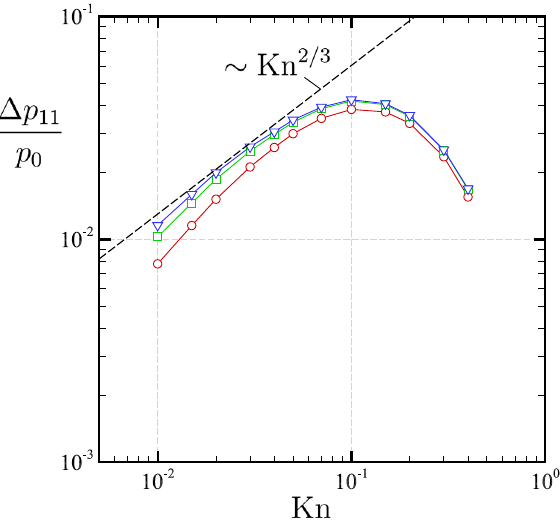
D D ( p 11 ( x 1 0, x 2 ) 0, 0 )) versus Kn . sup p 11 ( x 1 0 < x 2 < D / 2 2 + 2 + − = ≡ = D 0, 1 D ) is approximated by the node nearest to the corner (red circle), the linear 2 + 2 =